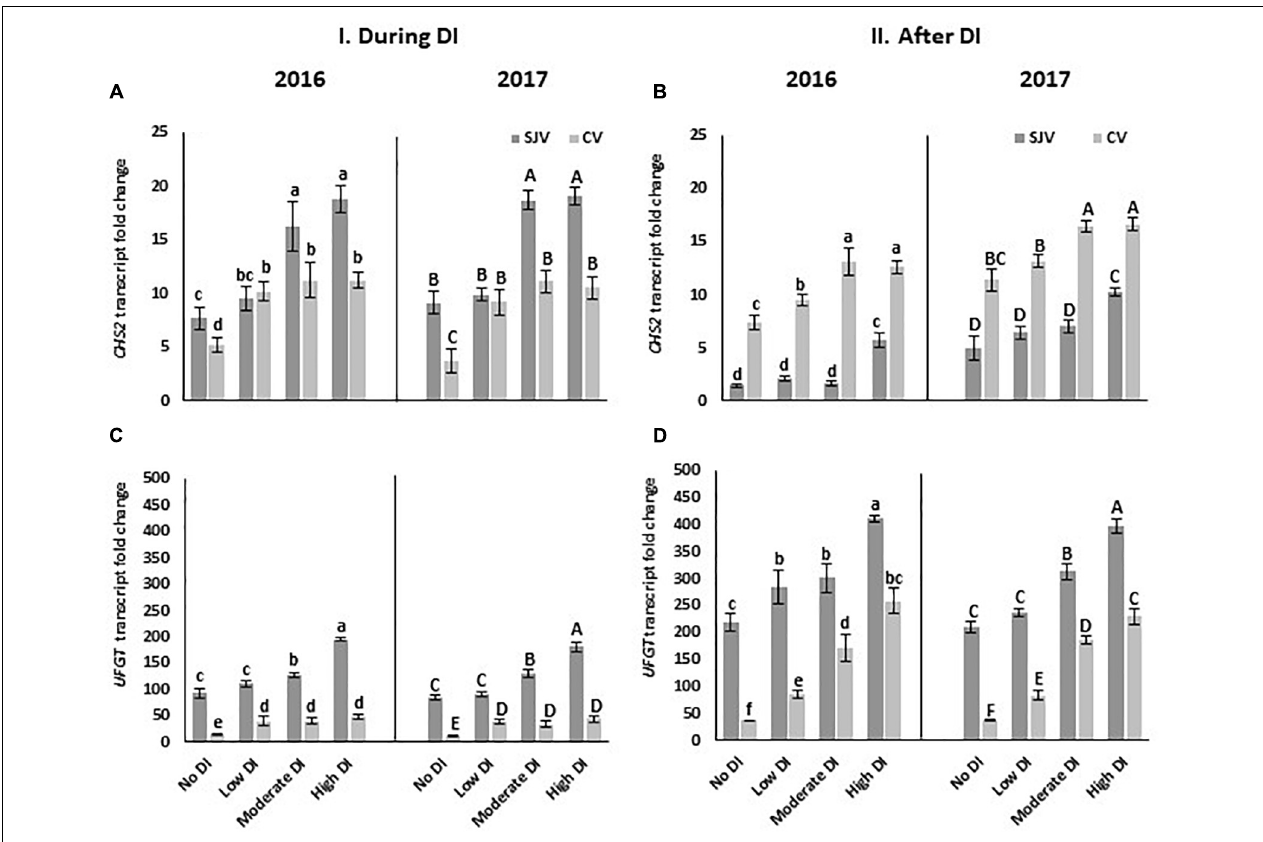
FIGURE 5 | Expression of genes involved in anthocyanin biosynthesis pathway in Scarlet Royal berry skin as affected by deficit irrigation (DI) treatments in 2016 and 2017, in San Joaquin (SJV) and Coachella (CV) Valleys. Genes involved in the anthocyanin biosynthesis are: chalcone synthase ( CHS2 ) (A,B) , and UDP-glucose: flavonoid-3-O-glucosyltransferase ( UFGT ) (C,D) . Gene expression was calculated during deficit treatment (I. During DI) and after re-irrigating vines with the original schedule (II. After DI). The error bars represent the standard deviation. Different letters on bars indicate significant differences among treatments and locations at p < 0.05 according to the Tukey HSD test within the same season. Different lower-case letters indicate a significant difference among treatments and locations in 2016 while capital letters are used for